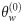
Sensitivity analysis of network community structure to filtering parameters.We consider a specific window 2000–2004 and the obtained plots are typical. (Left panel) We plot the number of communities as a function of the edge threshold parameter θw for different values of the node threshold parameter θc. The maximum is roughly stable across θc (dashed red line). (Right panel) To choose θc, we do a Pareto optimization on communities and network size: the compromise point (red overline) on the Pareto front (purple overline: possible choices after having fixed θw(0); blue level gives modularity) corresponds to θc = 0.06.